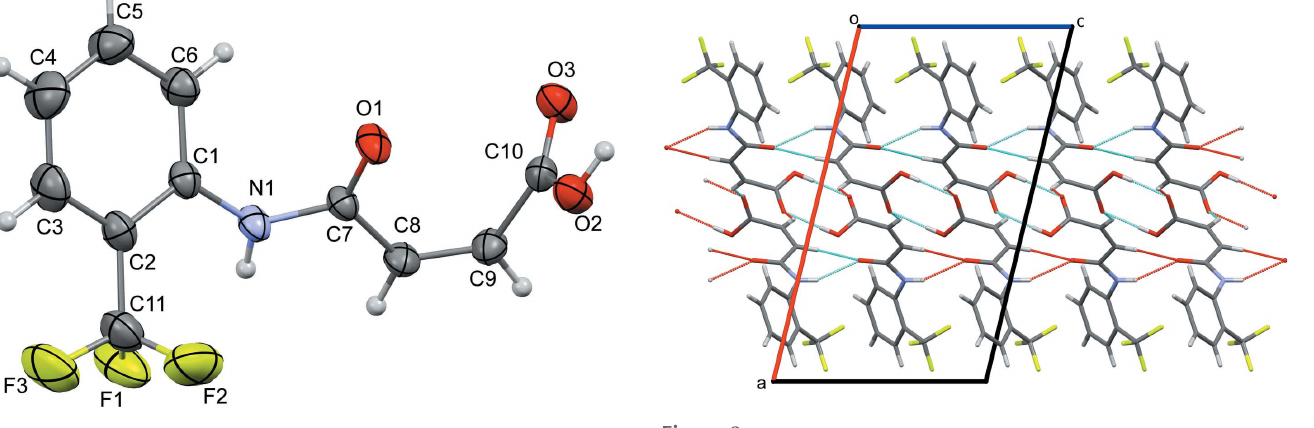
Figure 1 A view of the molecular structure of (I), with displacement ellipsoids drawn at the 50% probability